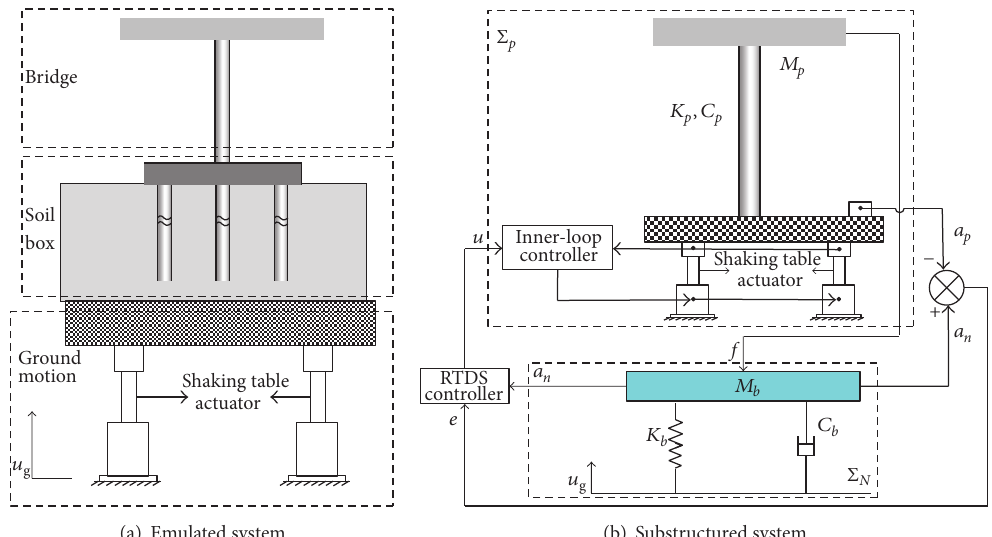
Figure 5: Framework of RTDS for SSI simulation.